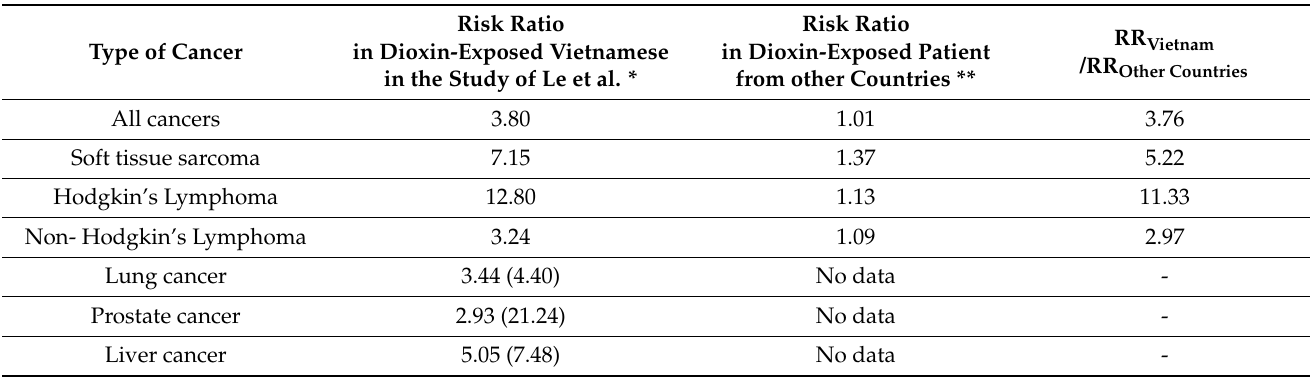
Table 5. Comparison of cancer incidence risk ratio for Vietnamese people with people from other countries exposed to